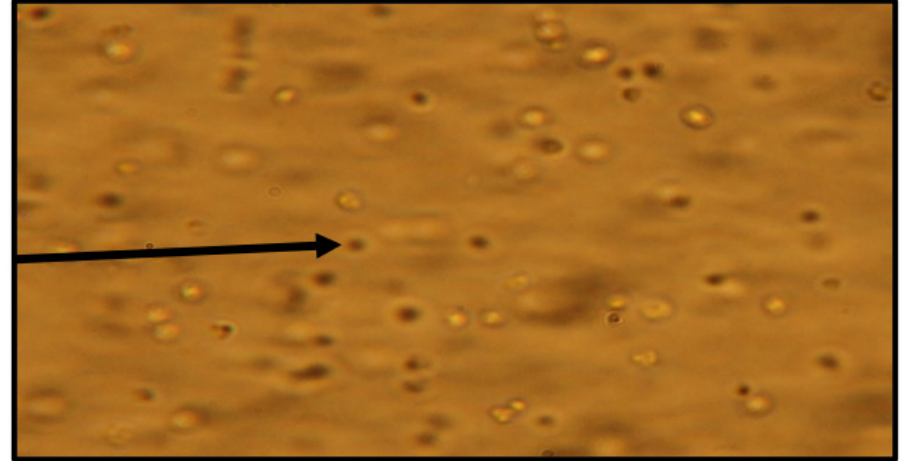
Figure 11. L. tarentolae treated with Compound 18 in DMSO (6.13 µg/mL) 143 h after treatment. 400× magnification. Arrow indicates individual cells; we observed low cell abundance, circular-shaped cells, flagella scarcity, and reduced motility.